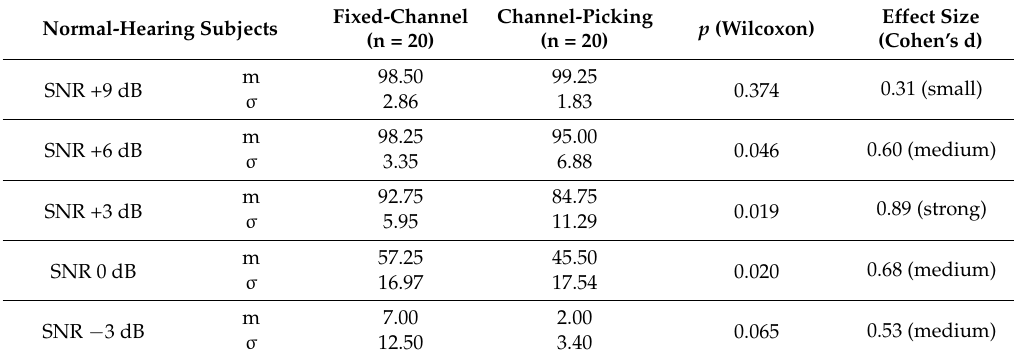
Table 2. Percentage comparisons for normal-hearing subjects between the simulation